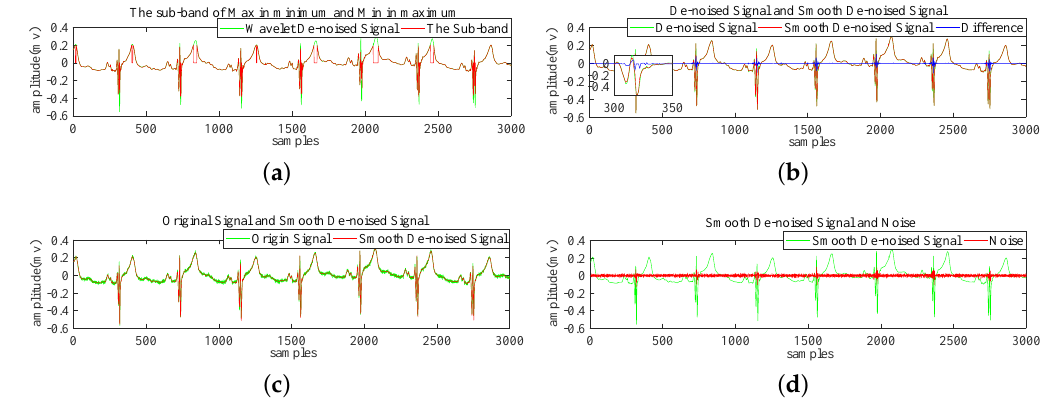
Figure 3. The results of de-noising 114 records in the MIT-BIH database: ( a ) Green is the signal de-noised by wavelet transform (including burrs), and red is the sub-band segmented by the minimum of maximum and the maximum of minimum. ( b ) The comparison between the signal after wavelet de-noising and the signal after wavelet de-noising and smoothing. ( c ) The comparison between the original signal and the signal after wavelet de-noising and smoothing. ( d ) The signal after de-noising and the resulting noise.